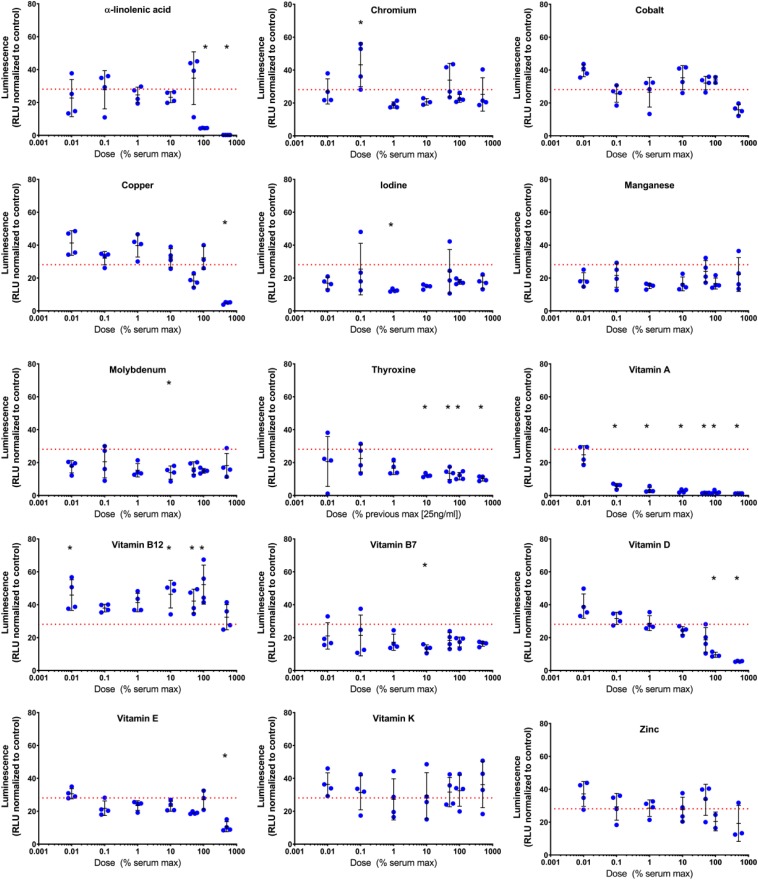
Day 21 evaluation of COL2A1 promoter-driven expression in vitamin and mineral supplemented TGFβ1 supplemented basal medium. Conditioned media was sampled at day 21 and assessed for luminescence, and normalized against the plate control basal medium. The red dashed line indicates the luminescence of the TGFβ1 supplemented basal medium. The symbol “*” significantly different vs. TGFβ1 supplemented basal medium, two-way ANOVA p < 0.05 Sidak’s multiple comparison test. Blue circles represent each data point.